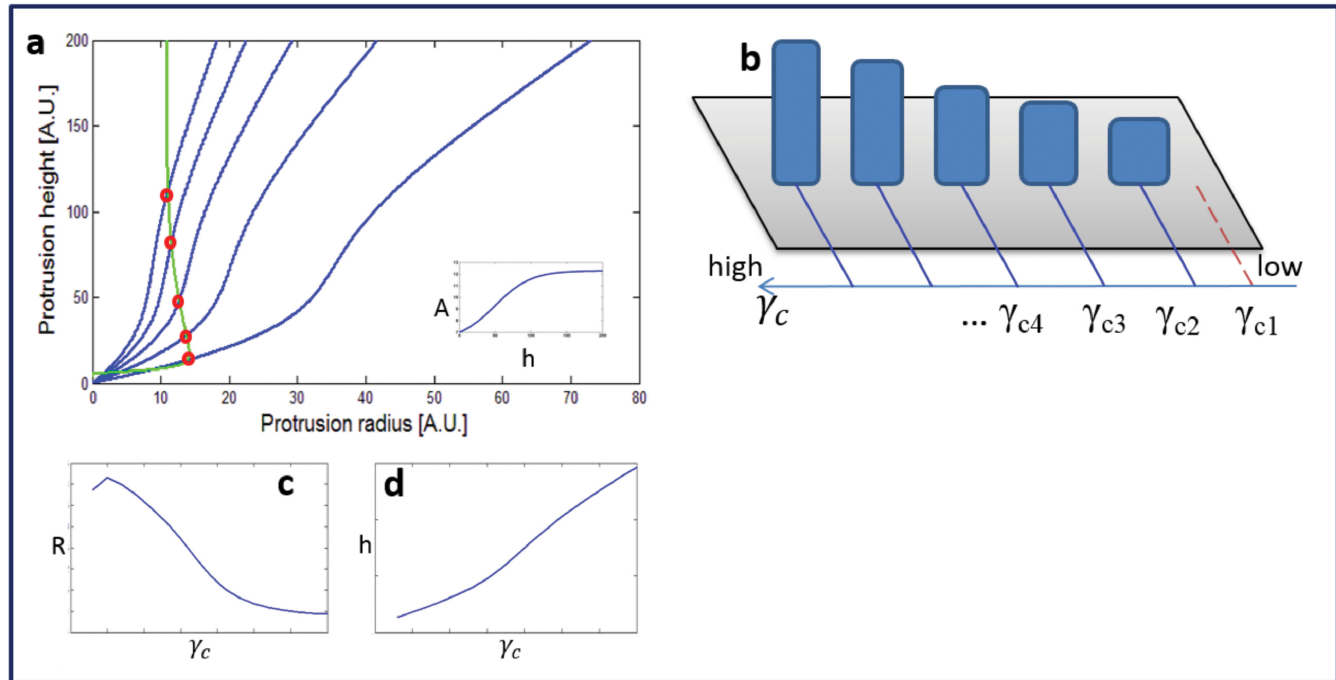
Fig 3. (a) Calculated heights and radii using the theoretical model, with the steady-state solutions indicated by the red circles. Here we take a linear spatial gradient in γ c , and a polymerization rate A ( h ) that increases with height (as shown in the inset). We get a staircase structure (b) with radii that become smaller for longer stereocilia (c), and a non-linear ratio in the heights of the rows (d). The non-linear growth of the height and the corresponding decrease in radius [2], are due to the increase in the polymerization rate A(h) with the